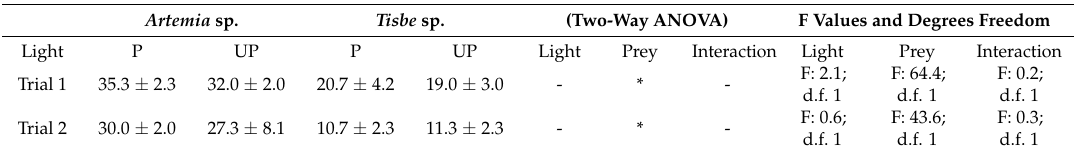
F: 2.1; F: 64.4; F: 0.2; d.f. 1 d.f. 1 d.f. 1 F: 0.6; F: 43.6; F: 0.3; d.f. 1 d.f. 1 d.f.